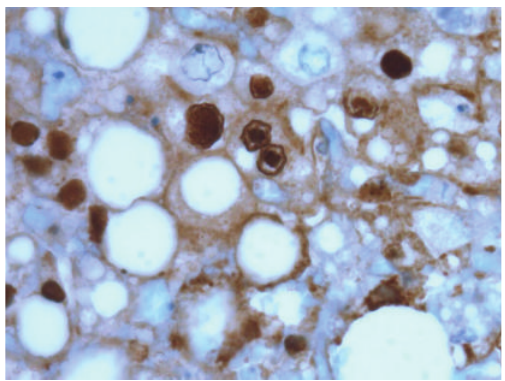
Figure 3: Immunohistochemistry for HSV virus highlights viral inclusions (600x